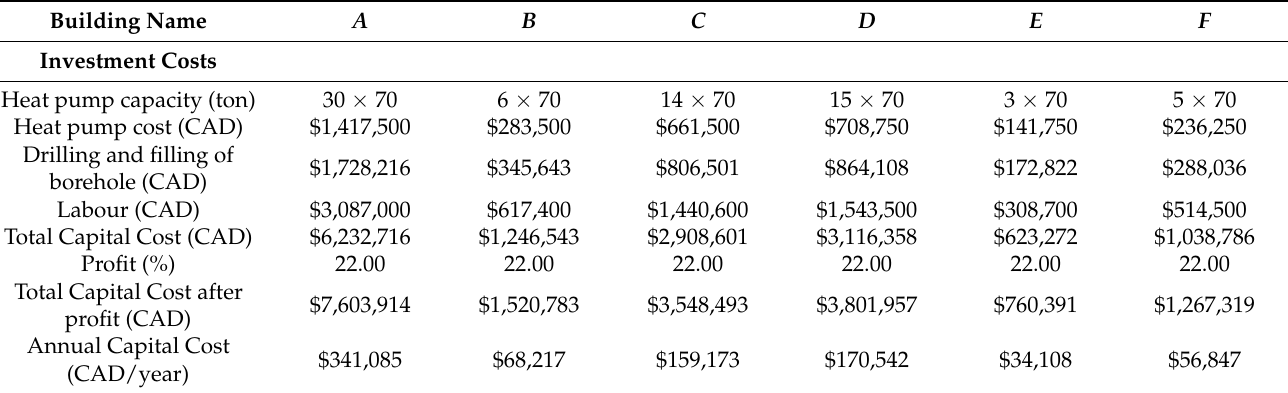
Table 7. Economic assessment of the first scenario (decentralized energy